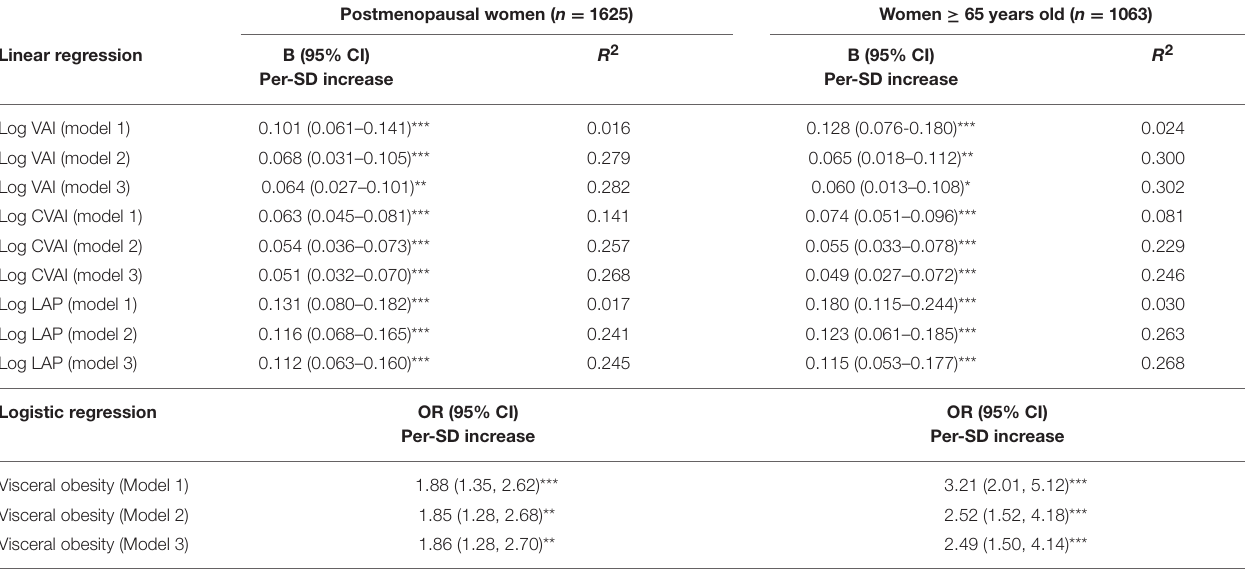
TABLE 6 | Association of LH/FSH ratio with visceral